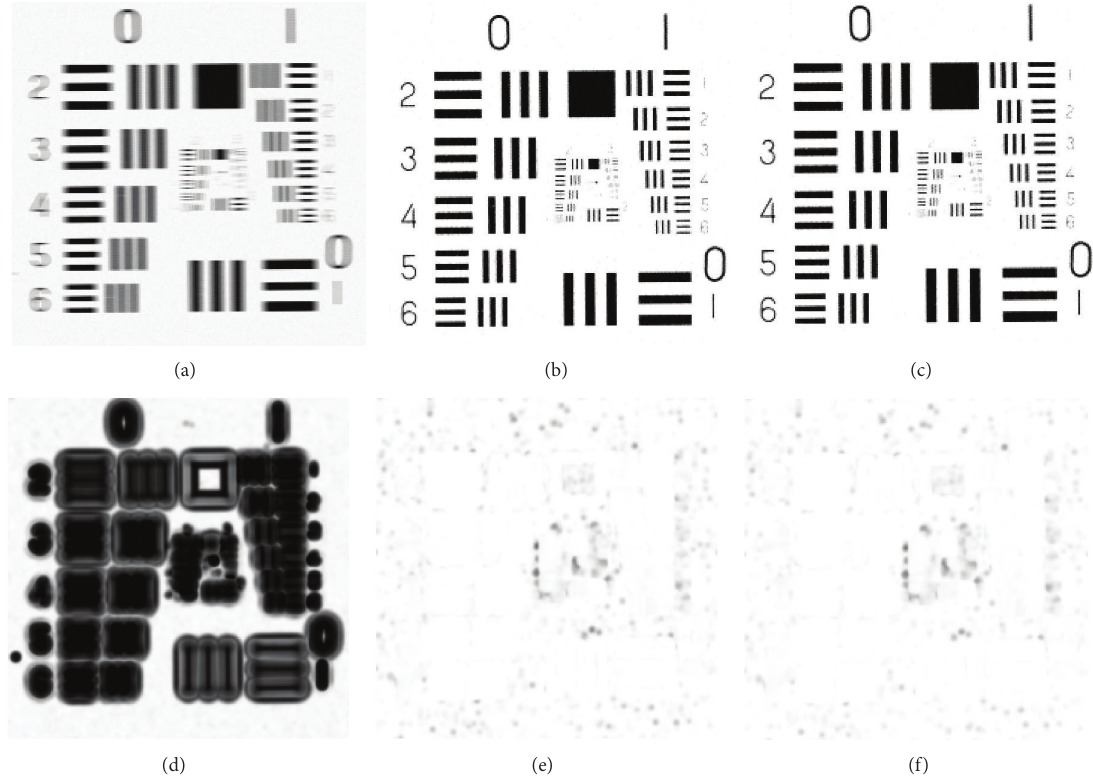
Figure 3: Results of different methods when restoring blurred and noisy image “Resolution Chart” degraded by motion blur with length 7 and a noise with BSNR = 30dB: (a) blurred and noisy image “Resolution Chart”; (b) restored image by FastTV; (c) restored image by FNDTV; (d) SSIM index map of the corrupted image; (e) SSIM index map of the recovered image by FastTV; (f) SSIM index map of the recovered image by